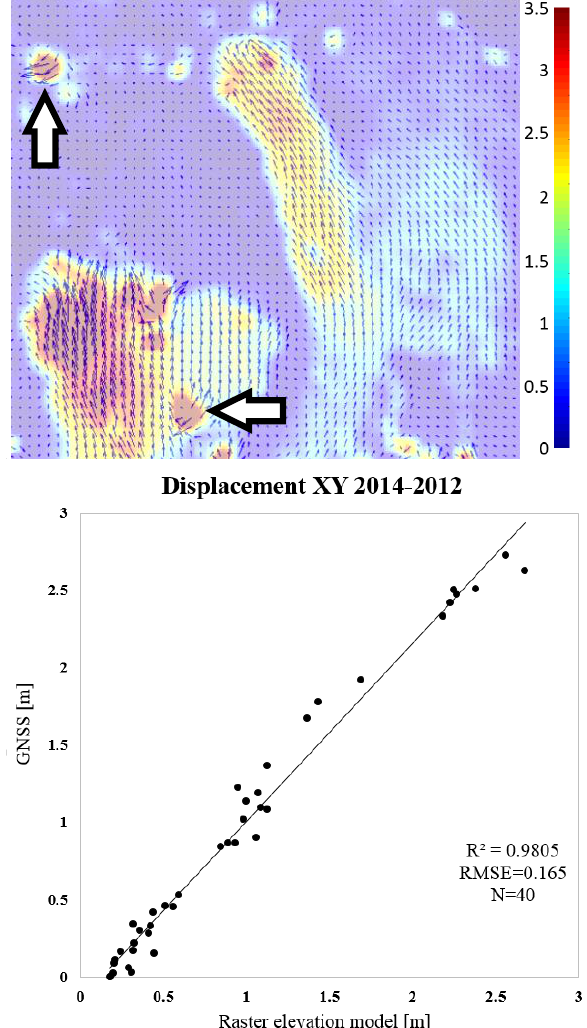
Figure 9. Top : 2D Displacement [m] coloured map obtained by ABM process on the DSM with related movements vectors calculated automatically (using a 10 pixel grid step). Bottom : Scatterplot between displacements obtained from the automatic comparison of UAS and GNSS measurements on 40